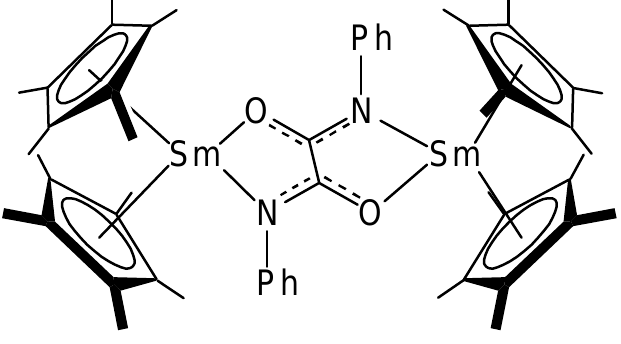
Me ) Sm} {(PhN)CO} 5 5 2 2